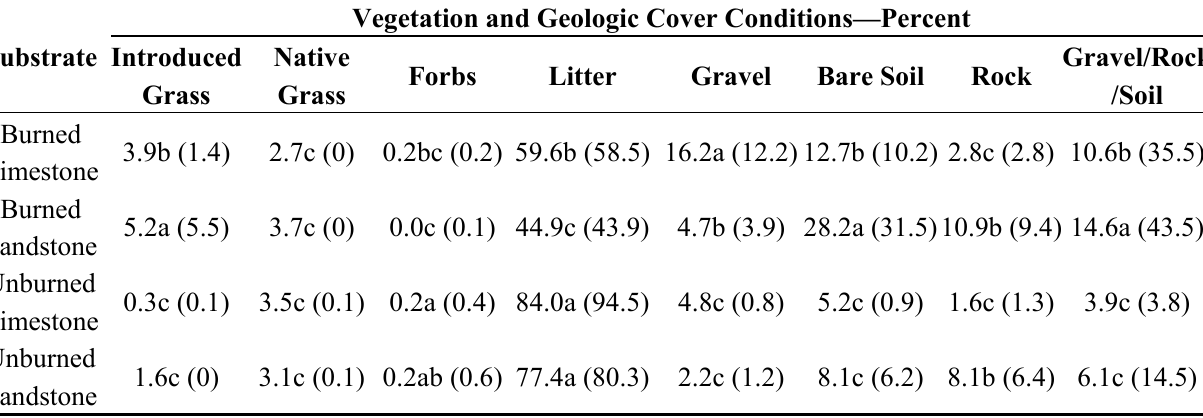
Table 6. Mean percent cover/plot (median percent cover/plot) for important cover categories across sandstone and limestone parent materials and burned and unburned conditions. Within a column, strata with the same letter are not significantly different according to the Peritz closure multiple comparison procedure, α = 0.10